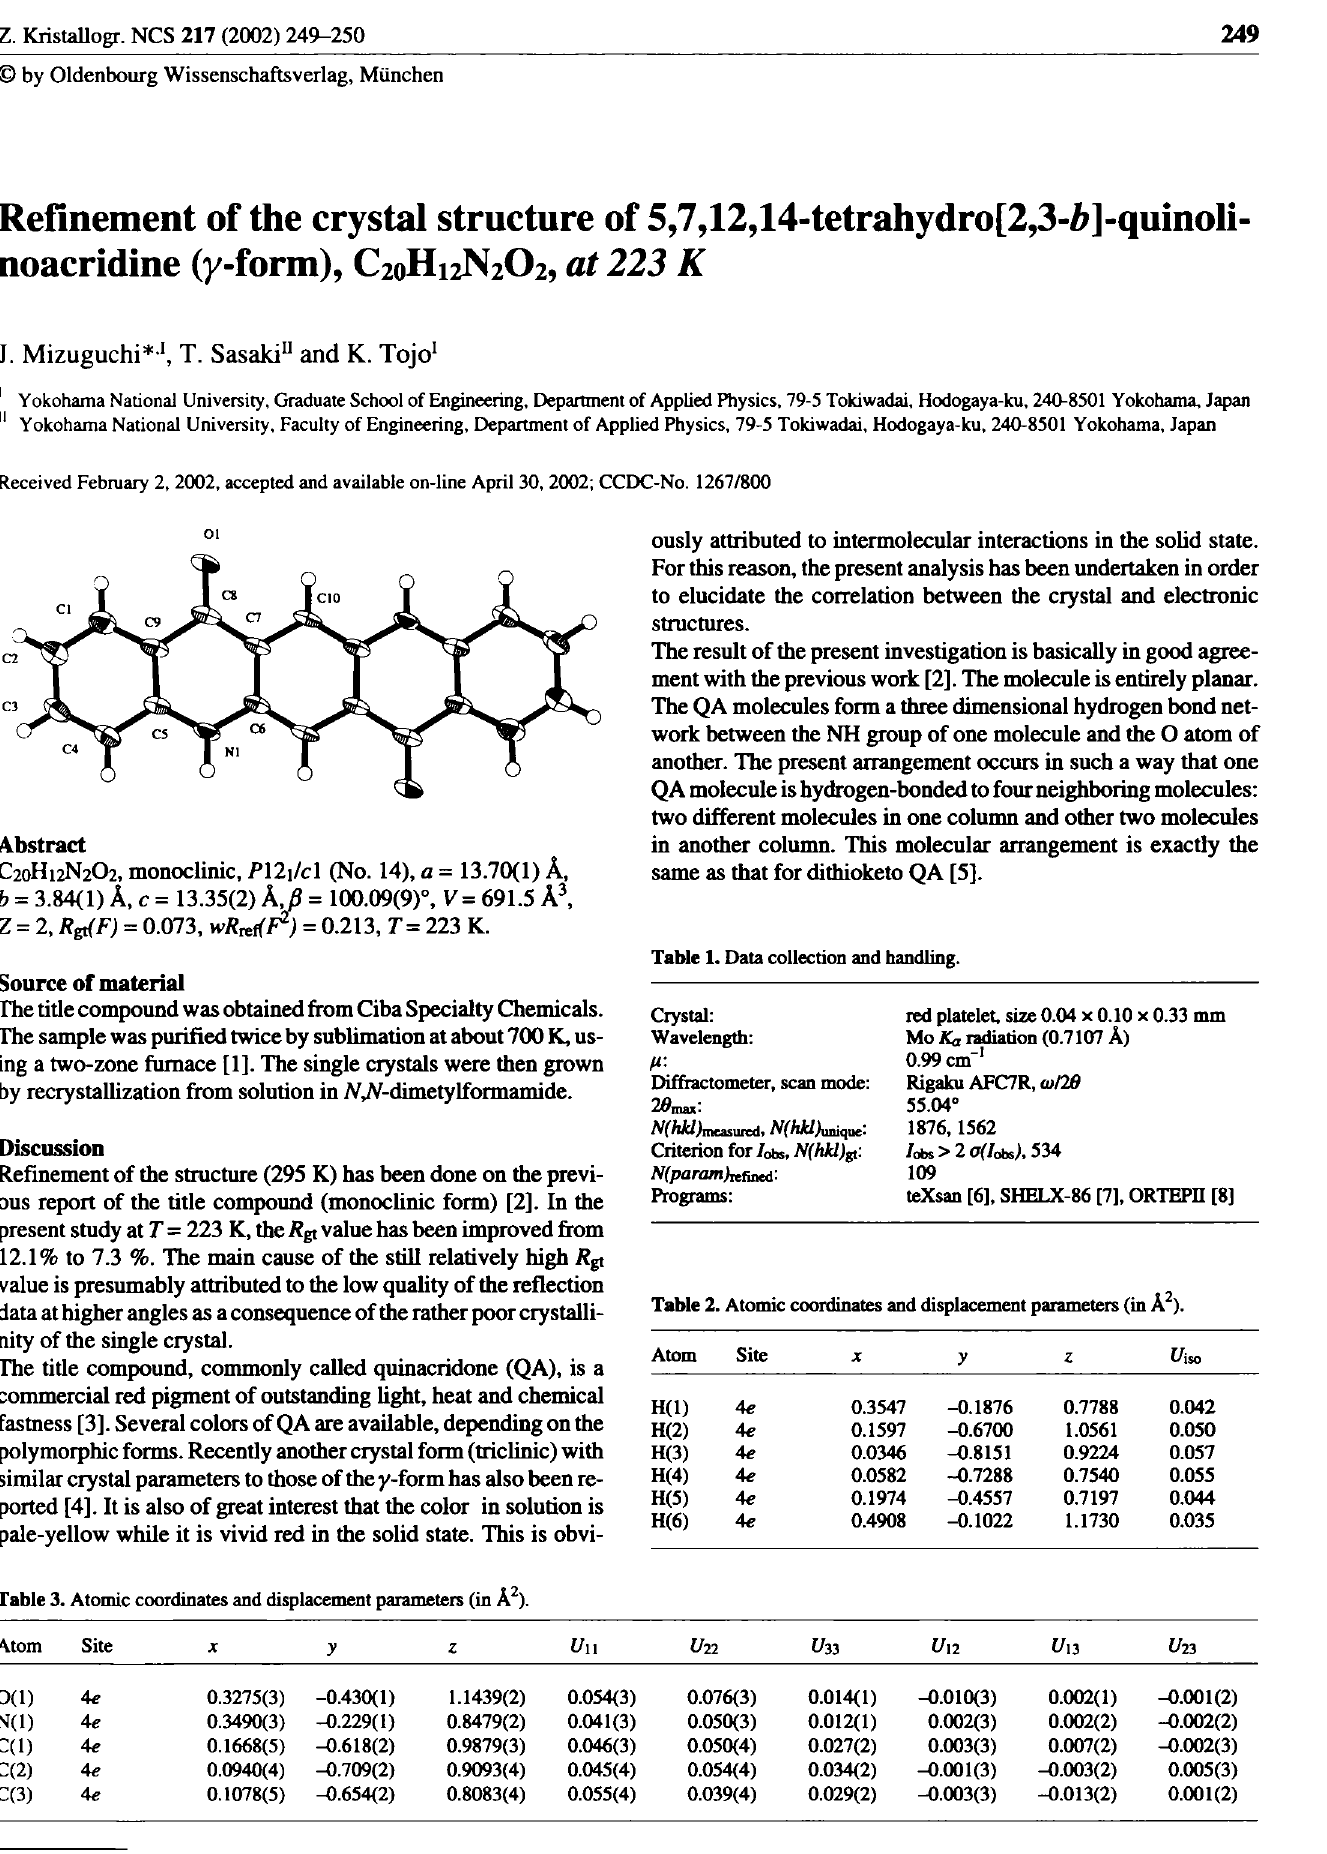
Table 3. Atomic coordinates and displacement parameters (in Â 2